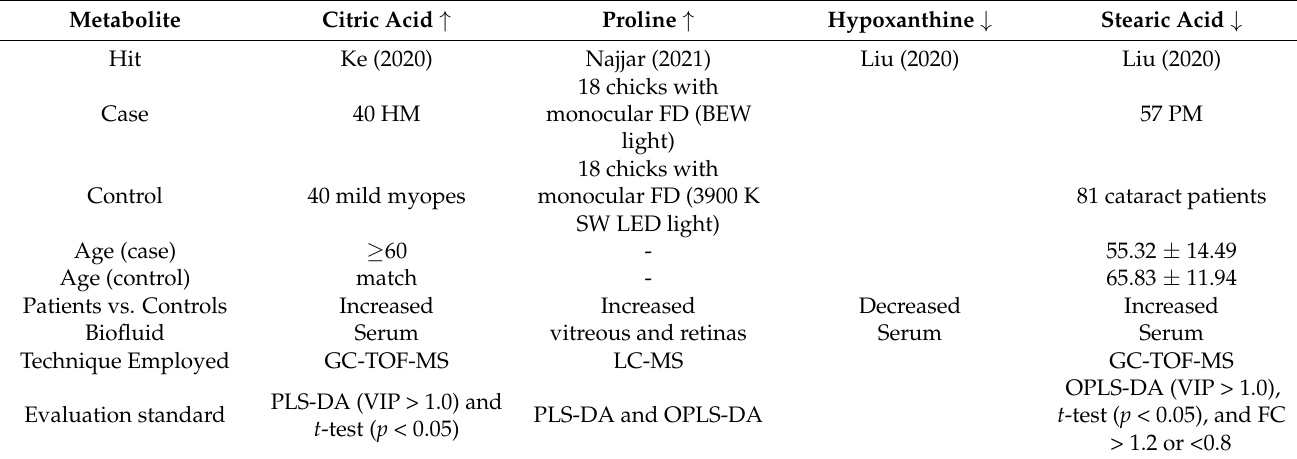
Table 3. Comparison with overlapping metabolites in myopic population